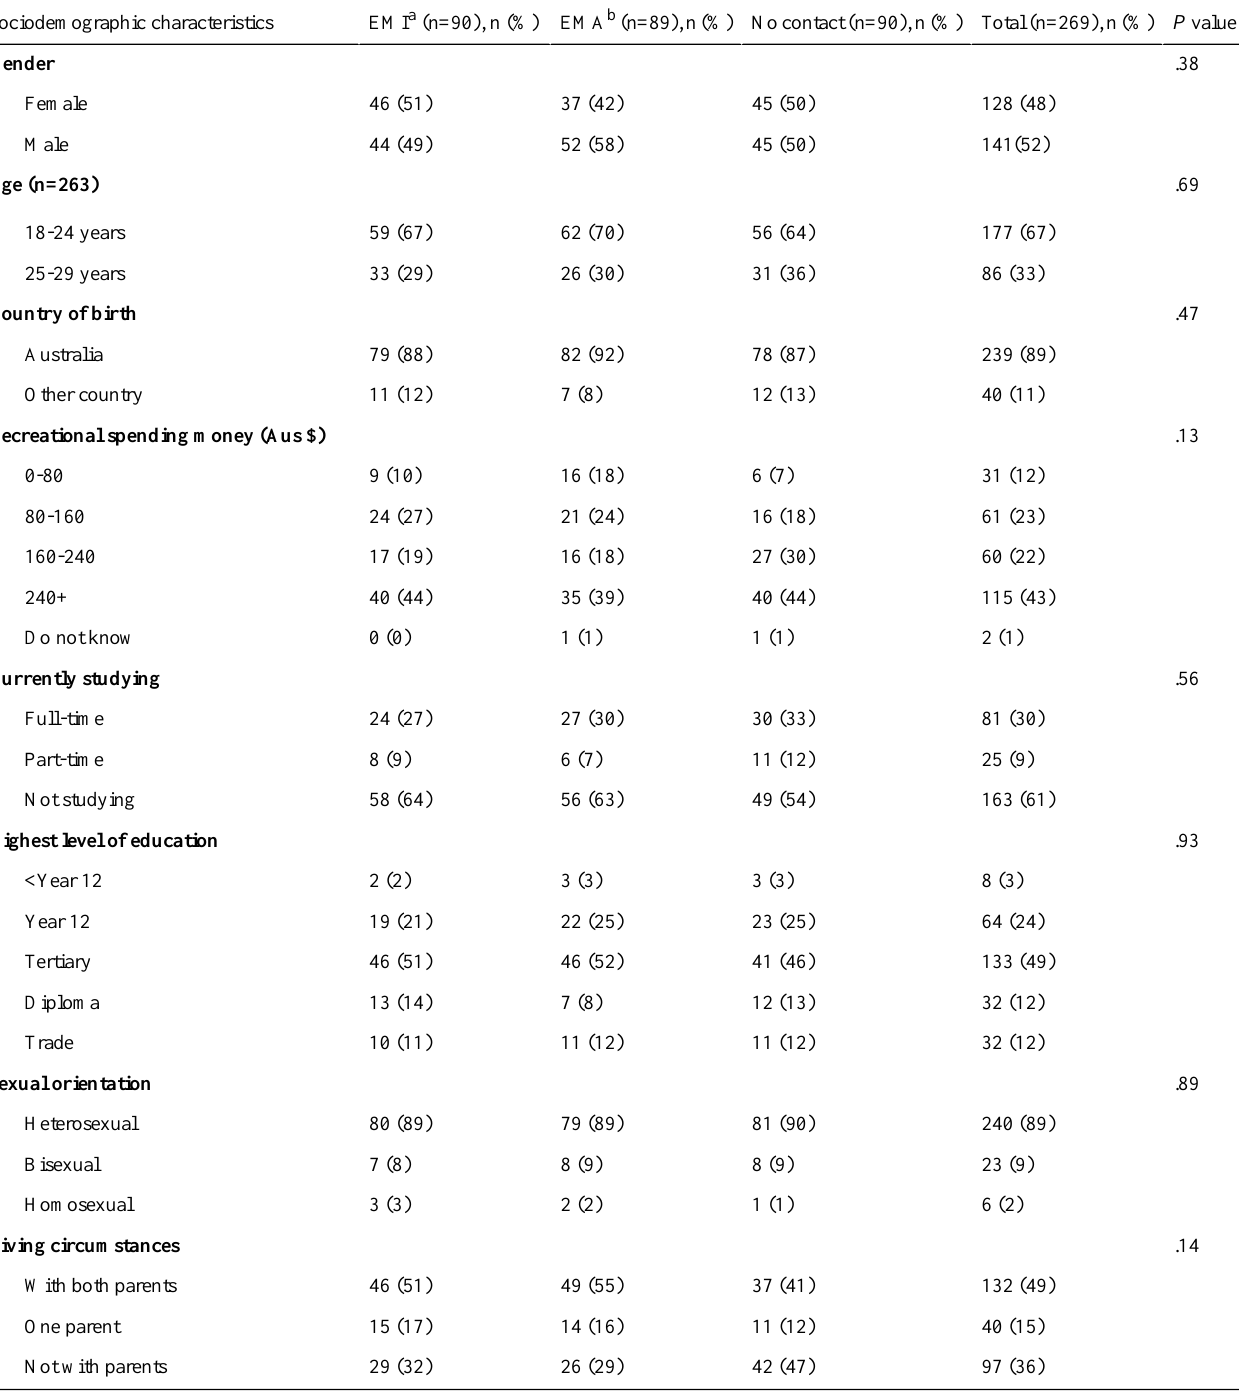
Table 1. Baseline sample characteristics by study group counts (n), percent (%), and probability values ( P values) from chi-square inferential